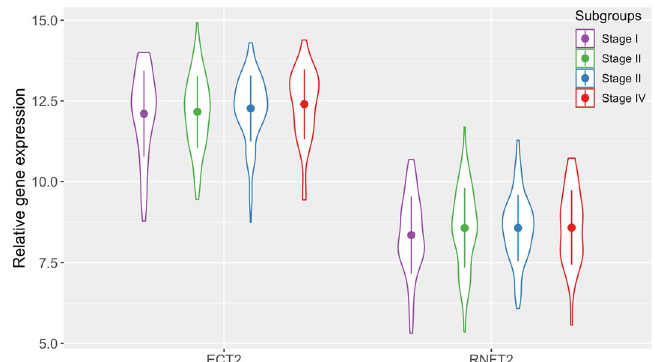
Figure 5. Relative expression levels of ECT2 and RNFT2 in tumor subgroups at virous stages. The violin boxplots depicted value ranges of the two genes, with the dot in each plot representing the average value.